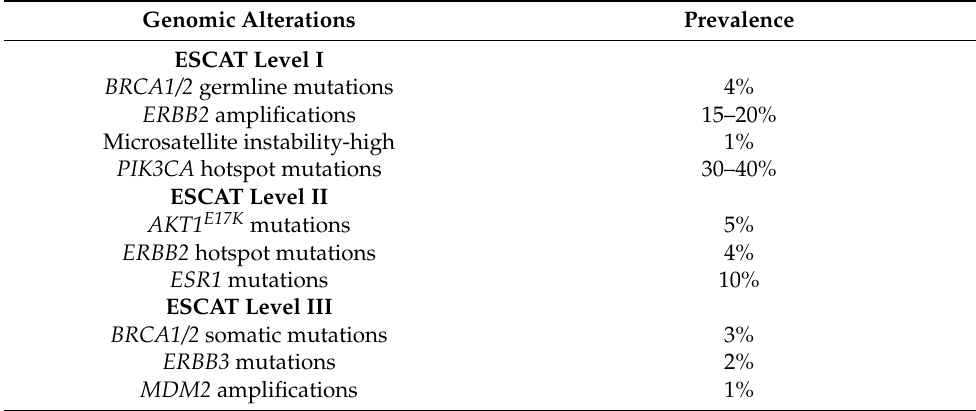
Figure 2. “The Informative Patient” study design. All procedures were conducted in the LMU University Hospital, Munich. Table 2. List of genomic alterations Level I/II/III in breast cancer as classified by the European Society for Medical Oncology (ESMO) Scale for Clinical Actionability of Molecular Targets (ESCAT) [27].